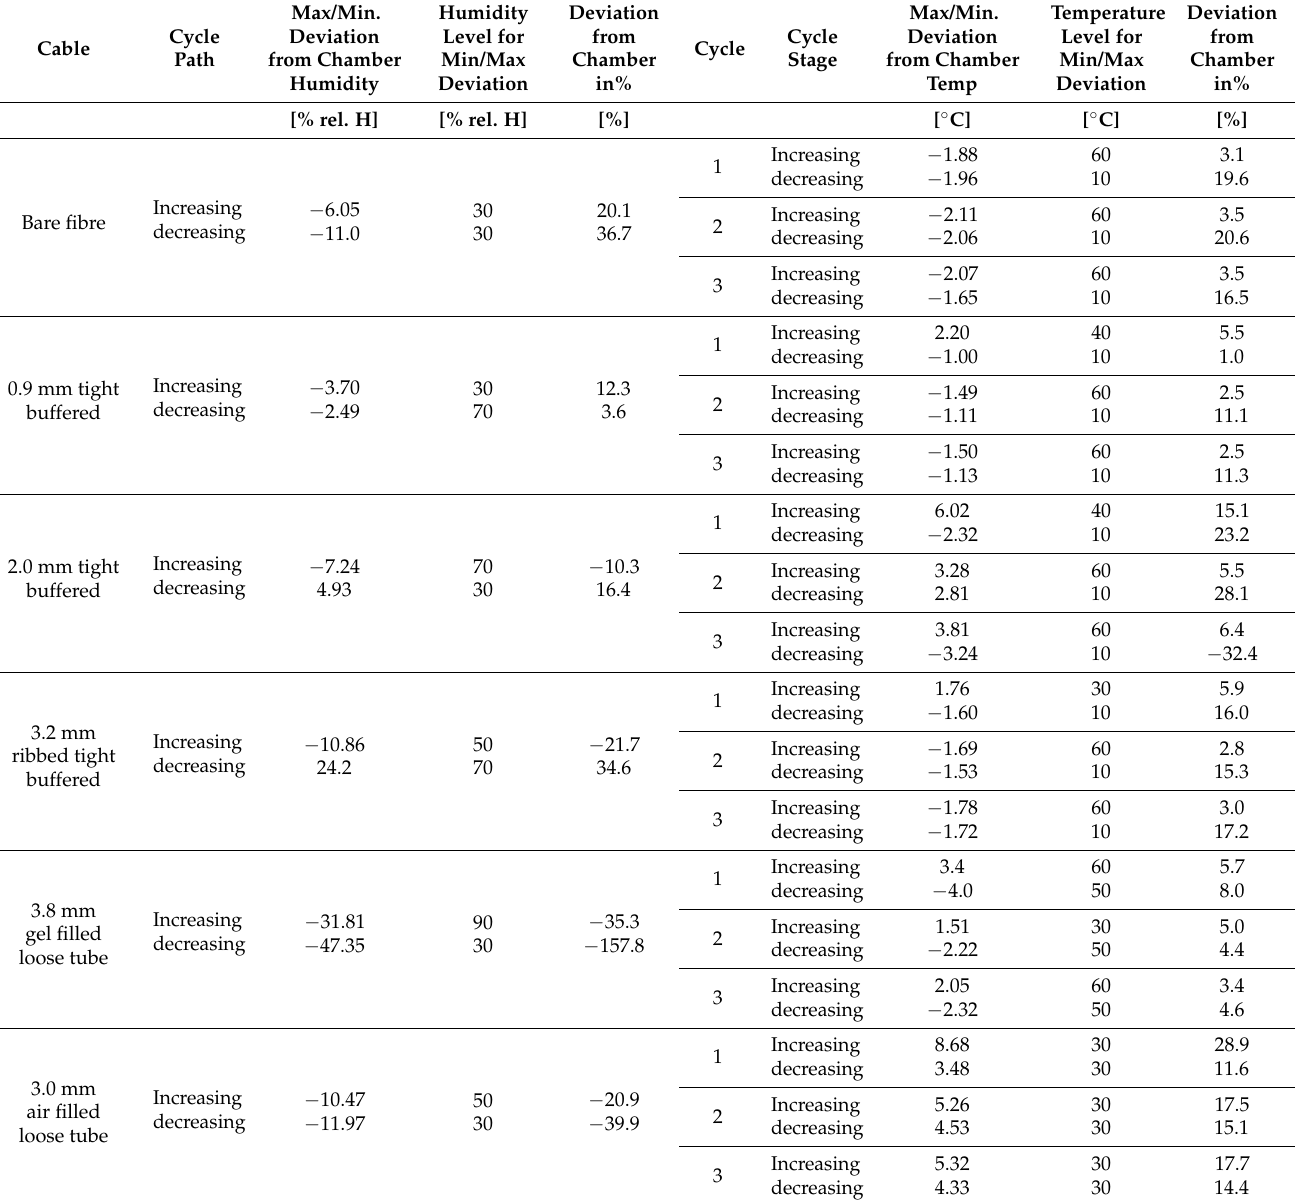
Table 8. Analysis of humidity and temperature deviation from the chamber